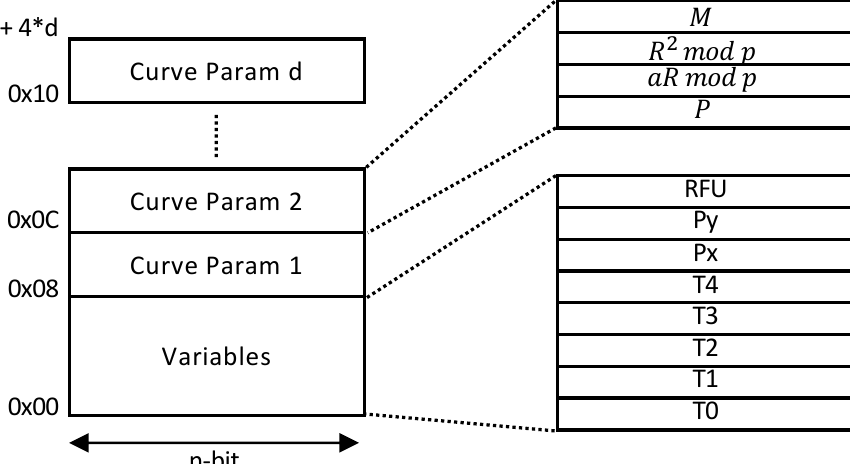
Figure 10. Address